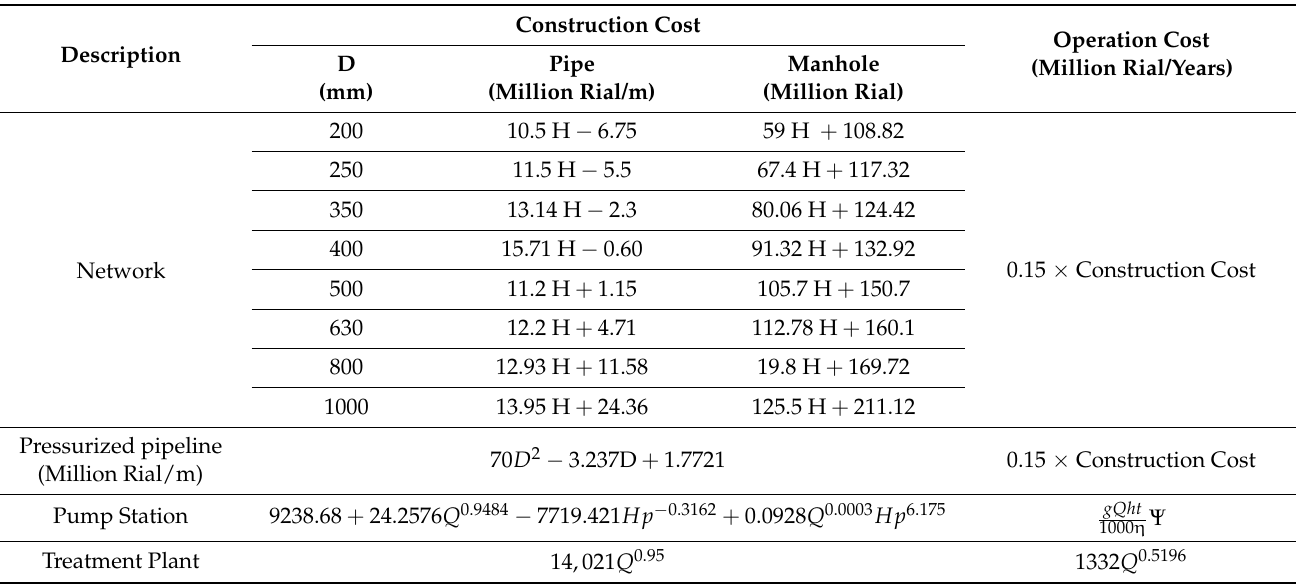
Table 3. The cost function of the case